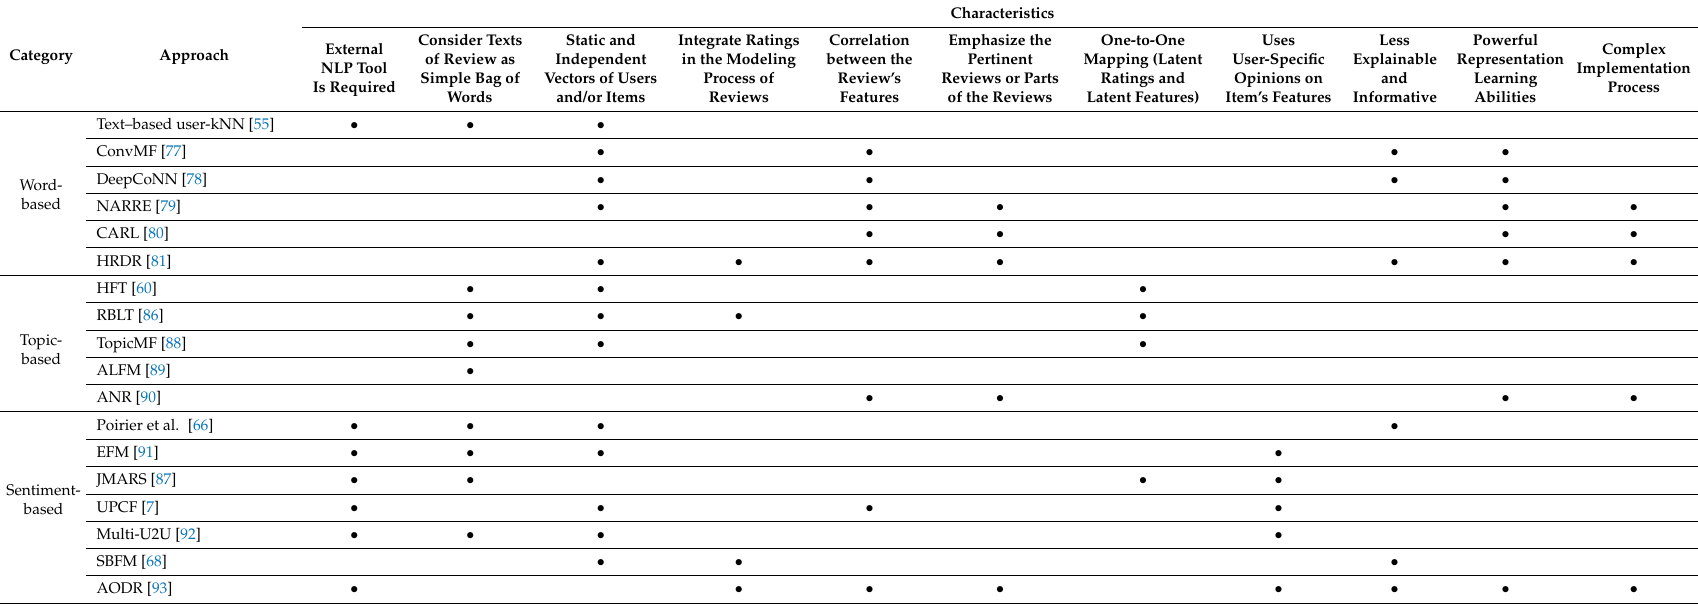
Table 6. Characteristics of review-based